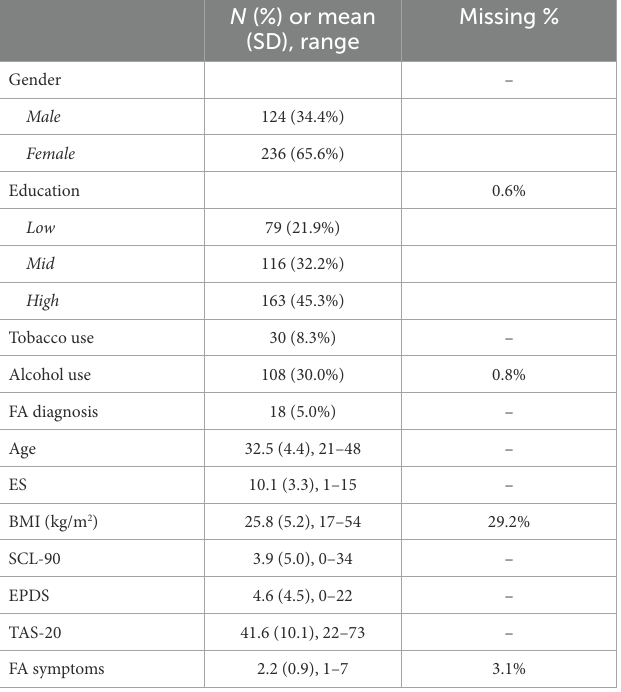
TABLE 1 Descriptive statistics for variables and the proportion of missing data.